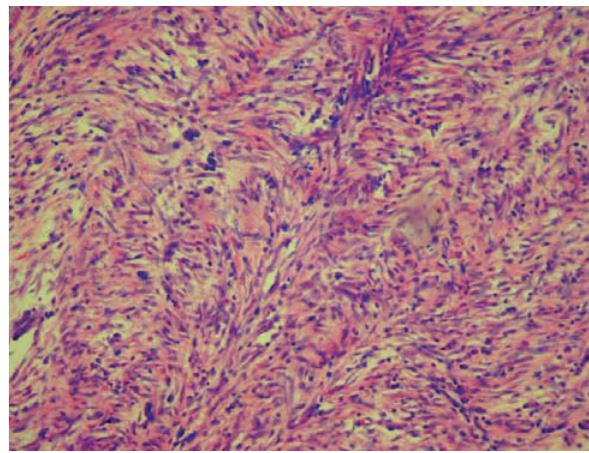
Fig. 4 – Tumor fibroso solitário – aspecto fasciculado sem padrão das fibras fusocelulares tumorais. Hematoxilina eosina (HE), 100X